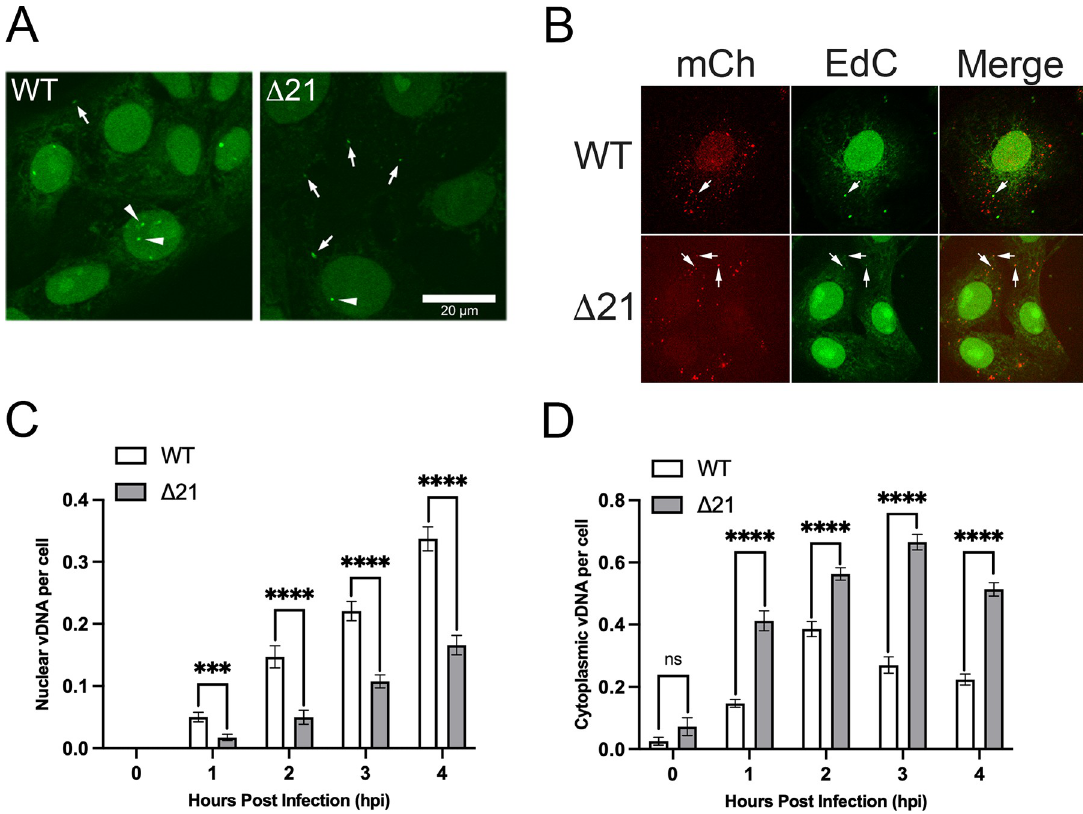
Fig 4. Comparison of genome retention of HSV-1 KOS WT and Δ 21 capsids during early infection. Vero cells were infected at an MOI of 0.1 with HSV-1 KOS WT or Δ 21 viruses containing EdC incorporated into their genomes. Infected cells were fixed at early times after infection (0–4 hpi) and genomes ejected from capsids were labeled using click-chemistry. A) Representative images of WT and Δ 21 infected cells at 4 hpi with ejected viral genomes labeled using click-chemistry. The scale bar is 20 μ m. Labelled genomes were identified as intense puncta seen in the cytoplasm (arrows) and nuclei of infected cells (arrowheads). Puncta were quantified and their numbers divided by the total number of cells to determine nuclear and cytoplasmic genomes per cell. B) Control experiment using EdC labeled HSV-2 186 WT or Δ 21 that produces mCh labeled nucleocapsids (MOI 3) showing that click-chemistry does not label genomes within capsids at 2 hpi. Arrows point to EdC labelled puncta that abut mCh labelled capsids. Note that the majority of mCh labelled capsids do not co-localize with an EdC signal. C) The quantification of nuclear viral genomes (vDNA) per cell over 0–4 hpi is shown (n = 21 images per timepoint and condition). D) The quantification of cytoplasmic genomes (vDNA) per cell over 0–4 hpi is shown (n = 21 images per timepoint and condition). Unpaired t-tests were performed between Δ 21 mutants and WT viruses for three biological replicates. ��� and ���� represent p � 0.001 and p � 0.0001, respectively.